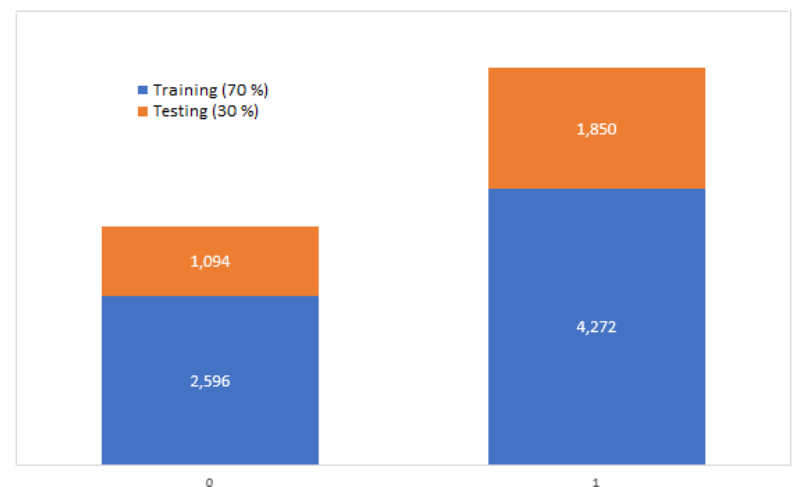
Figure 5. Graph of the number of subjects that belongs to each dataset, training and testing. The content in the bar with “0” presented a status of absence of caries, while the contest in the bar with “1” presented a status of presence/restoration of